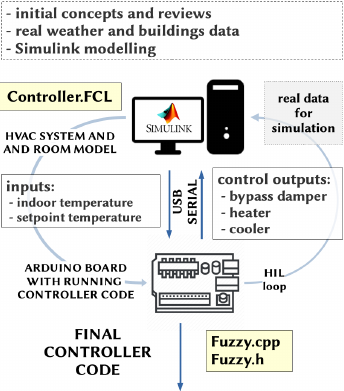
Figure 11. The simulation setup. The plots of indoor temperature for one of the model rooms plotted together with external temperature for single days are shown in Figures 12 and 13. All simulations started from an initial temperature (T_init, T_cabin in Simulink model) of 25 ◦ C (A) with a constant air volume. The setpoint was constant for the entire simulation time. AHUs generally operate with a fixed temperature, or it is changed at most a few times during the day